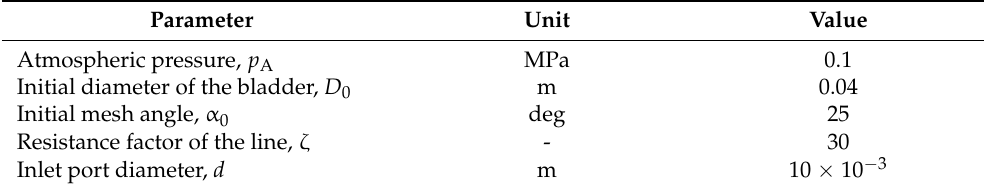
Table 4. The initial parameters for numerical modeling of the operator force static